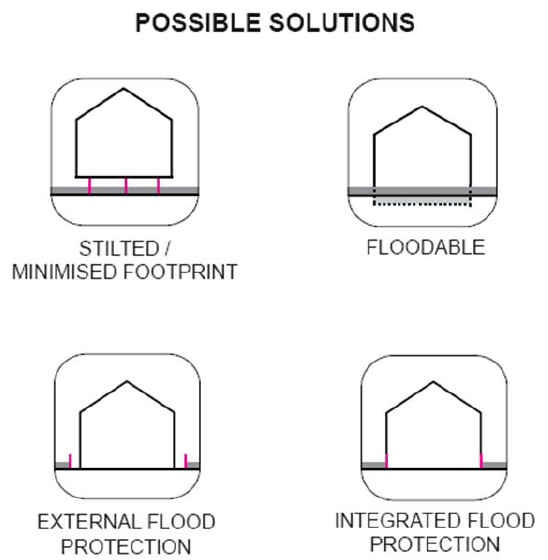
Fig. 6. Various solutions for structural resilience against flood hazard (Redeker, 2010).